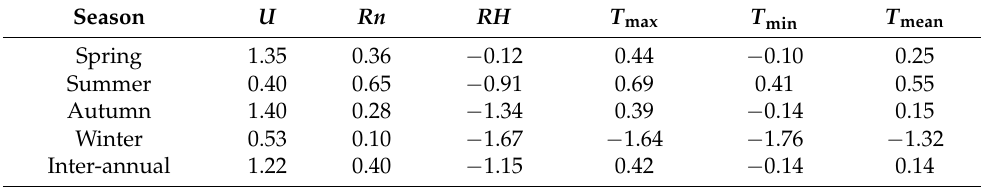
Table 2. Sensitivity coefficients of seasonal and inter-annual ET 0 change to climate factors. Season